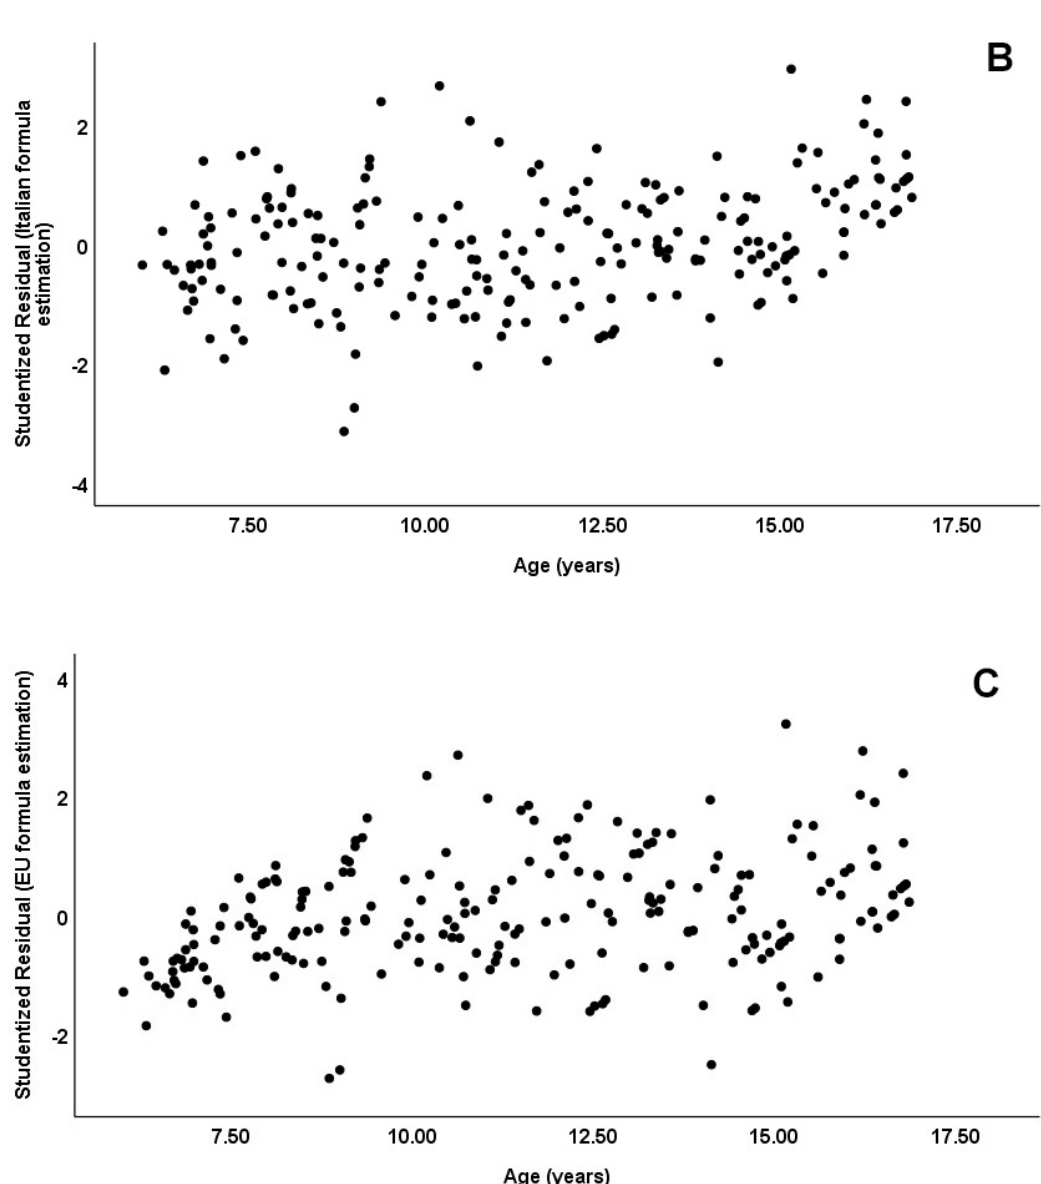
Figure 1. The residual plots (( A ): Sardinian, ( B ): Italian and ( C ): European formula).